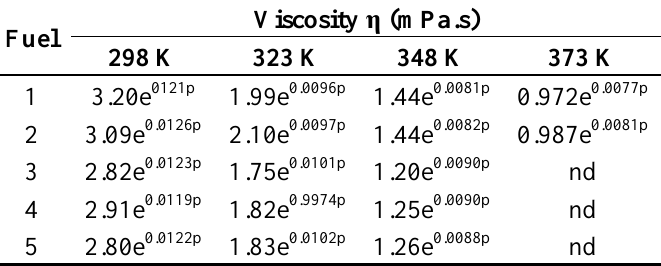
Table 3. Viscosity correlations with pressure for Fuels 1 to 5.